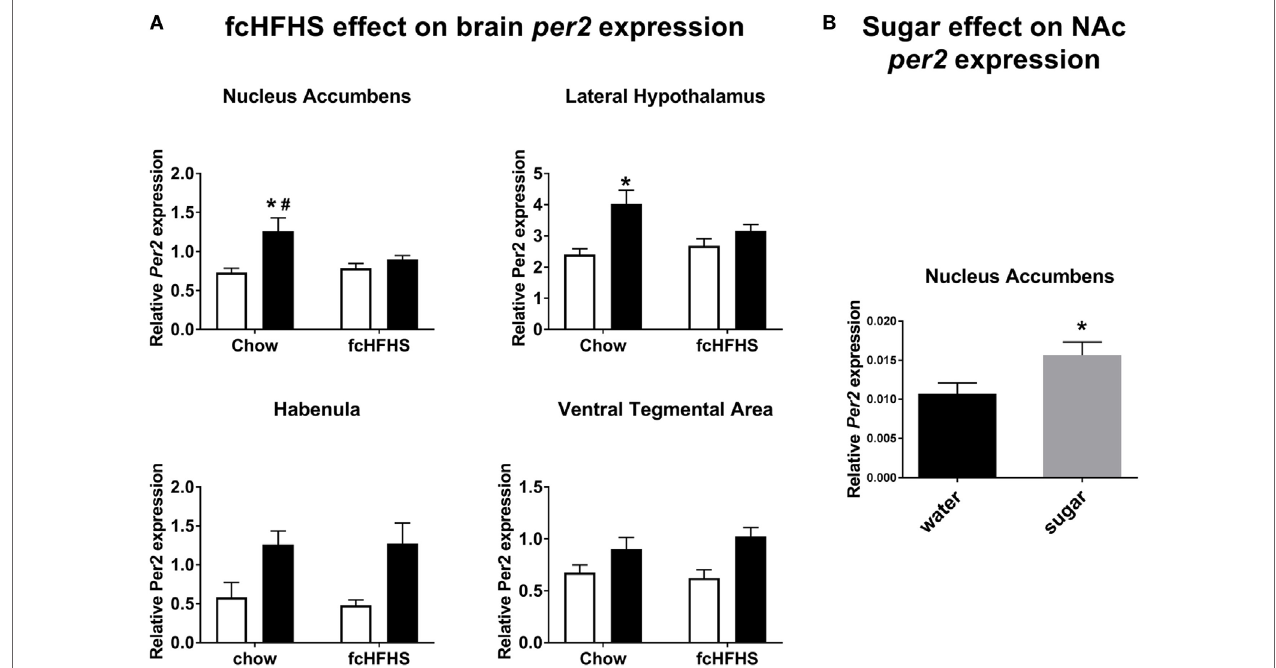
FigUre 1 | Per2 mRNA expression in nucleus accumbens (NAc) and lateral hypothalamus, but not habenula or ventral tegmental area, is altered by free-choice high-fat high-sugar (fcHFHS) diet exposure. (a) Day (white bars) night (black bars; time factor) expression of Per2 in chow diet vs. fcHFHS diet groups (diet factor). All the structures showed significant day–night variations, and when an interaction was observed. * indicates a significant day–night difference of Per2 expression; and # indicates a significant effect of diet (chow vs. fcHFHS) on Per2 expression at night. (B) Per2 mRNA expression in the NAc is significantly higher after sugar drinking compared with water drinking in chow-fed rats. * indicates a significant difference in Per2 expression after water intake vs. sugar intake. Data are presented as mean ±